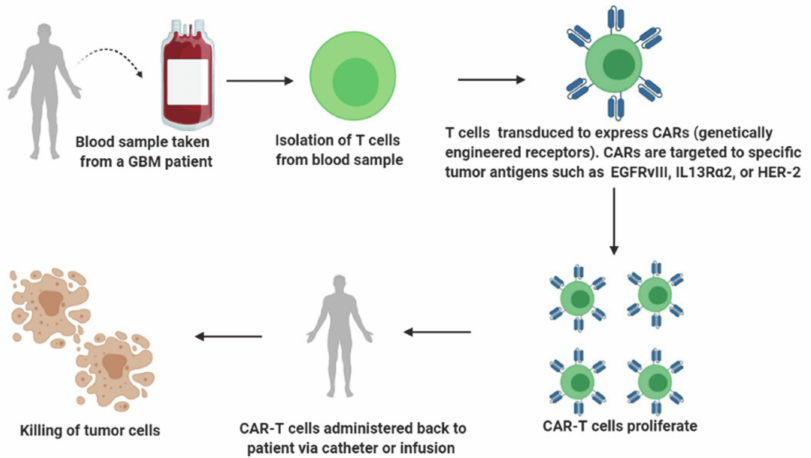
Figure 4. A brief overview of adoptive